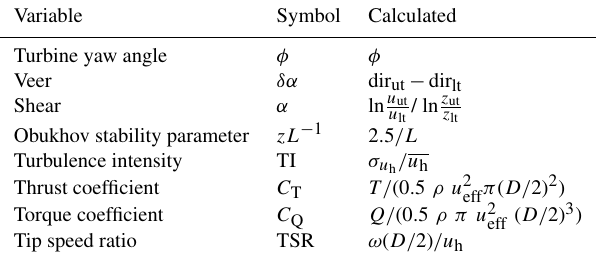
Table 3. Set of dimensionless input parameters: dir is the wind di- rection [ ◦ ], z is the height above the surface [m], u h and σ u the mean and standard deviation of the wind speed at hub height [ms − 1 ], u eff is rotor effective wind speed [ms − 1 ], T is thrust [N], Q is torque [Nm], and ω is rotor speed [rads − 1 ]. Subscript ut indi- cates upper-tip and lt lower-tip